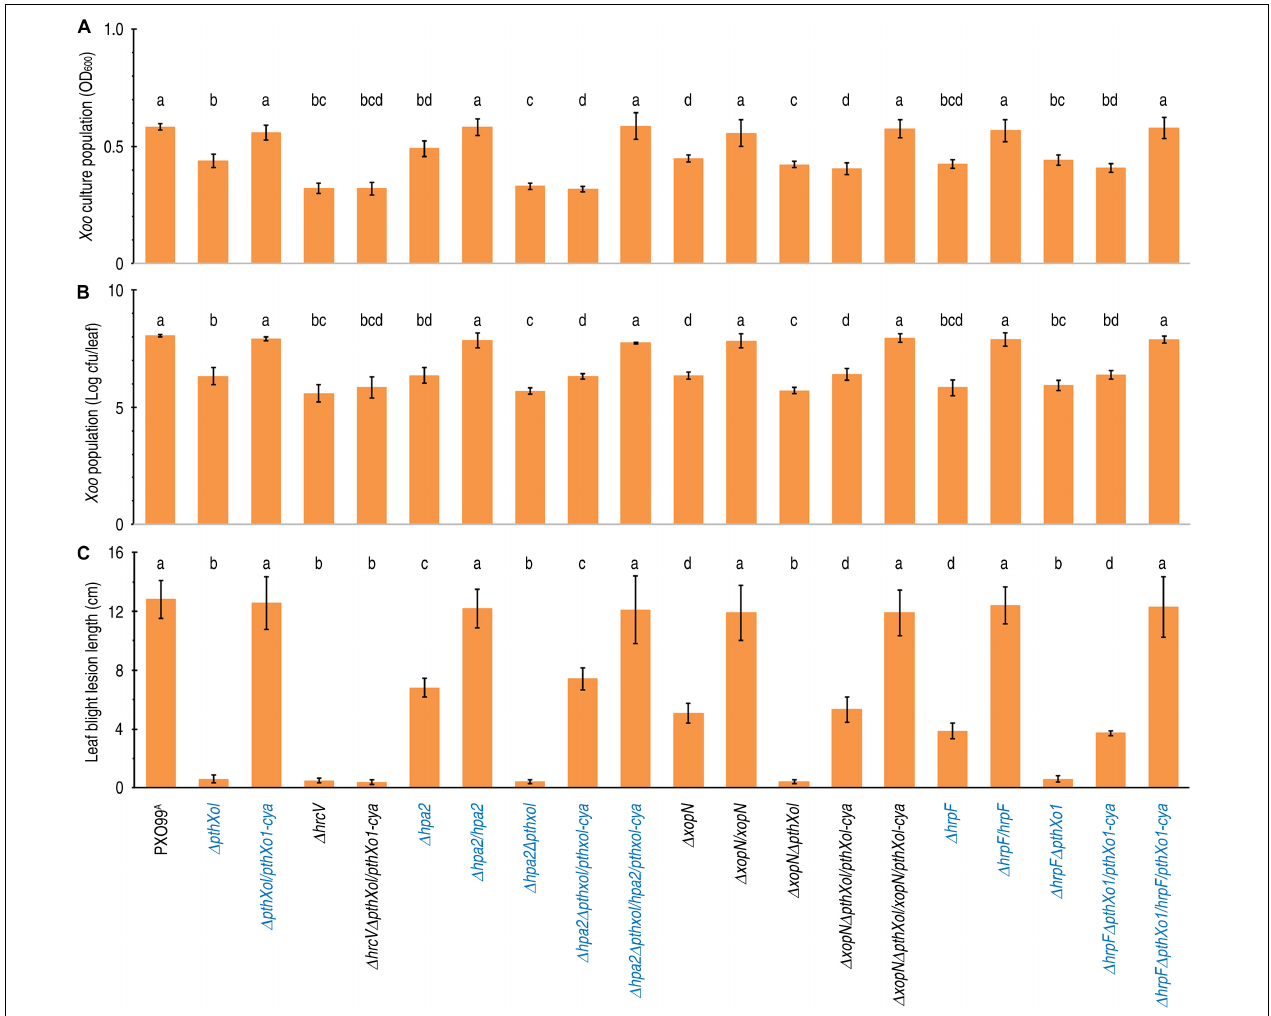
FIGURE 1 | The effects of hpa1 , hpa2 , hrpF , and hrcV on Xoo bacterial multiplication in culture and virulence on the susceptible rice variety Nipponbare. (A–C) The Xoo WT strain PXO99 A and its mutants generated by deleting the corresponding genes were tested in parallel experiments. Data shown are mean values ± standard deviation (SD) estimates. Number of biological repeats ( n ) = 6 independent experiments in (A) ; n = 30 inoculated leaves from 15 plants tested in 3 independent experiments in (B) and (C) . Different letters on bar graphs indicate significant differences of data obtained from the experiments performed on the different bacterial strains (ANOVA and Duncan’s test, P < 0.001 in (A) and (C) , P < 0.005 in B ). (A) Bacterial populations of the different Xoo strains in a liquid medium after 20-h incubation. (B) Populations of bacteria multiplied in leaves. Leaves of 30-day-old Nipponbare rice seedlings were inoculated by leaf-top clipping with clinical scissors immediately dipped in the corresponding bacterial suspensions of the Xoo strains. Three days later, bacterial population in leaf tissues were determined. (C) Lesion length of bacterial blight on leaves 12